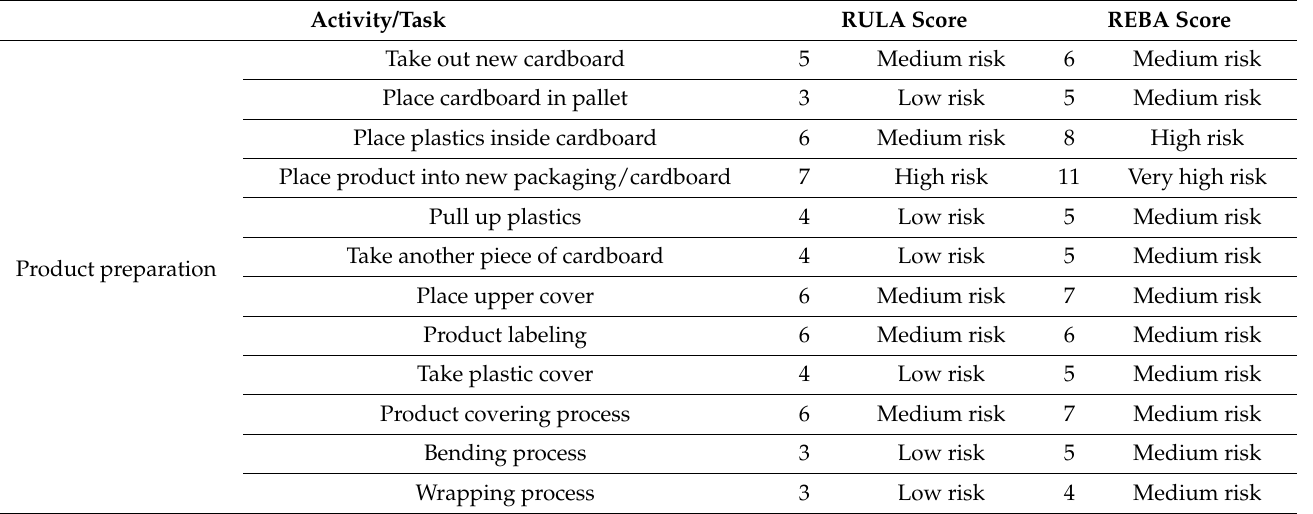
Table 5. RULA and REBA